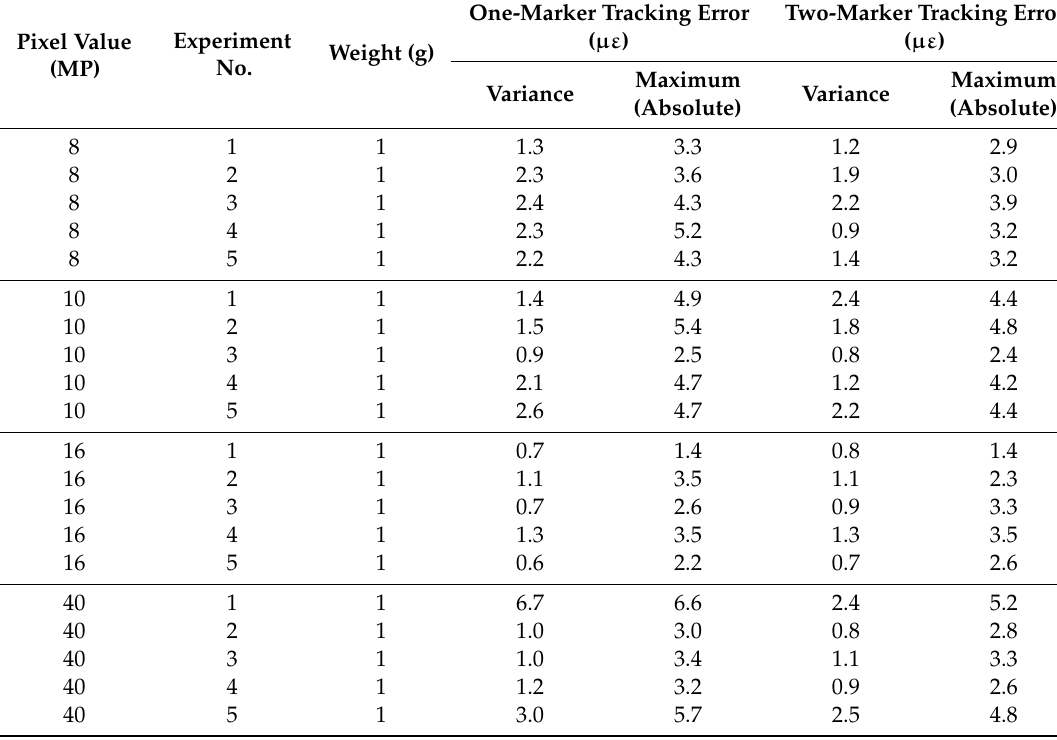
Table 3. Errors of measurement results using FBG and